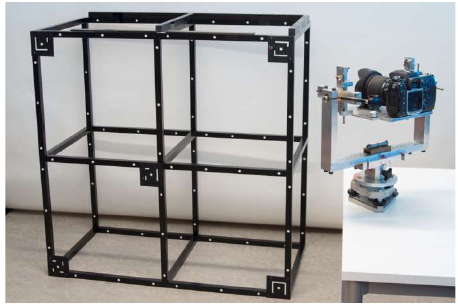
Figure 1. The non-motorized reference platform and the calibration rig.